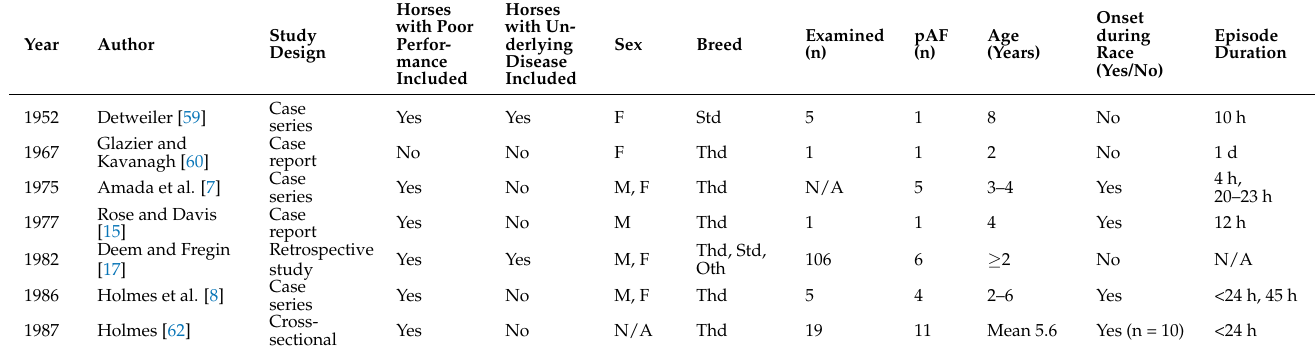
Table 1. Paroxysmal atrial fibrillation (pAF) in horses. The table provides an overview of previous studies reporting on pAF in horses, including specifics of the different study populations and disease duration. Horses with poor performance included: “Yes” if horses had poor performance on the day of examination, “No” if the horses included did not present with clinical signs. Number of horses with pAF only includes self-terminating episodes lasting less than 48 h. Breed: Thd = Thoroughbred, Std = Standardbred, Oth = other. AF = atrial fibrillation. Gender: M = male, F = female,